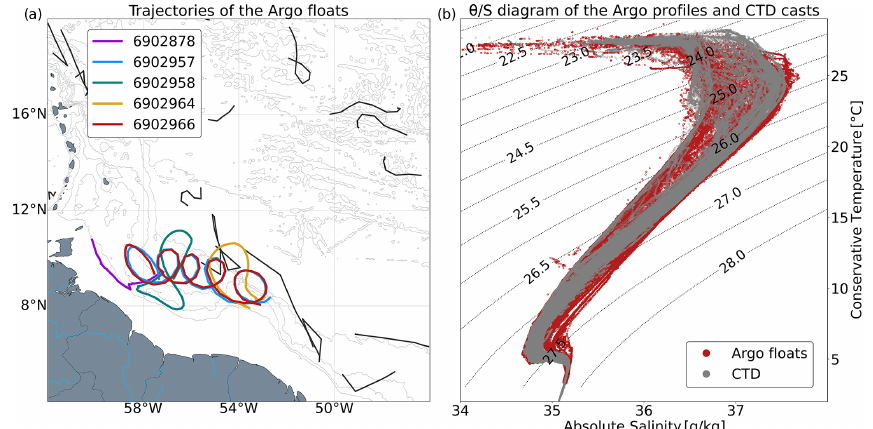
Figure 18. (a) Map of the Argo floats found in the region of interest between December 2019 and May 2020; specific colors are attributed to the five floats deployed from R/V L’Atalante . (b) θ /S diagram of the Argo floats, compared to nearby CTD casts. No clear bias is observed